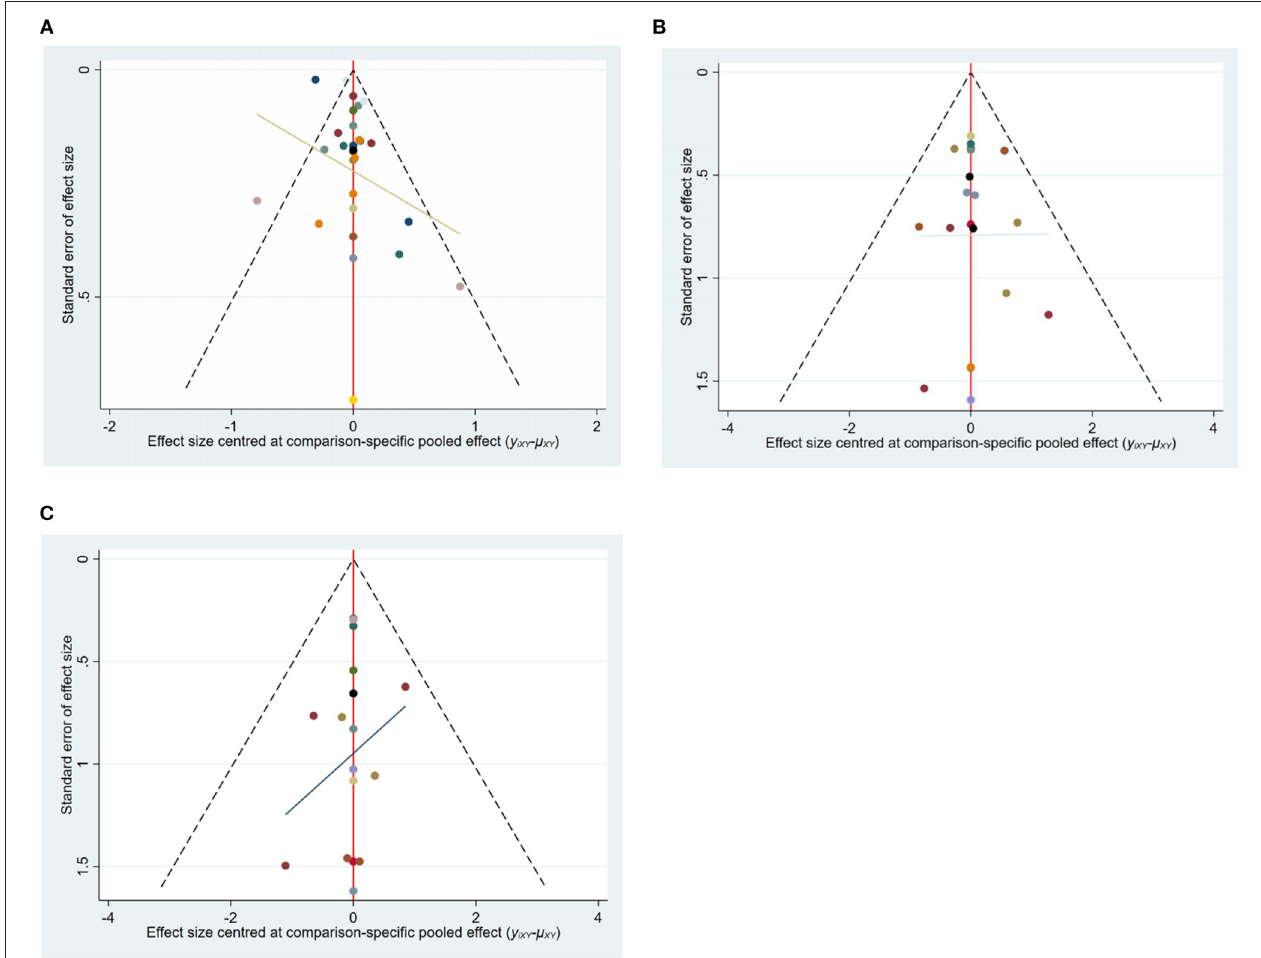
FIGURE 3 | The funnel plot of outcome measures. (A) Funnel plot for cure rate; (B) Funnel plot of recurrence rate; (C) Funnel plot of complication